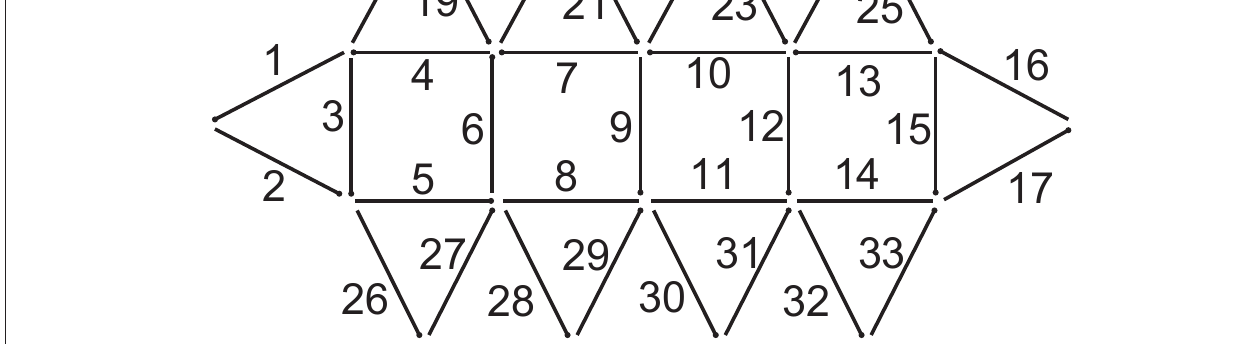
FIGURE 7: Terry’s drawing procedure for Term 4.